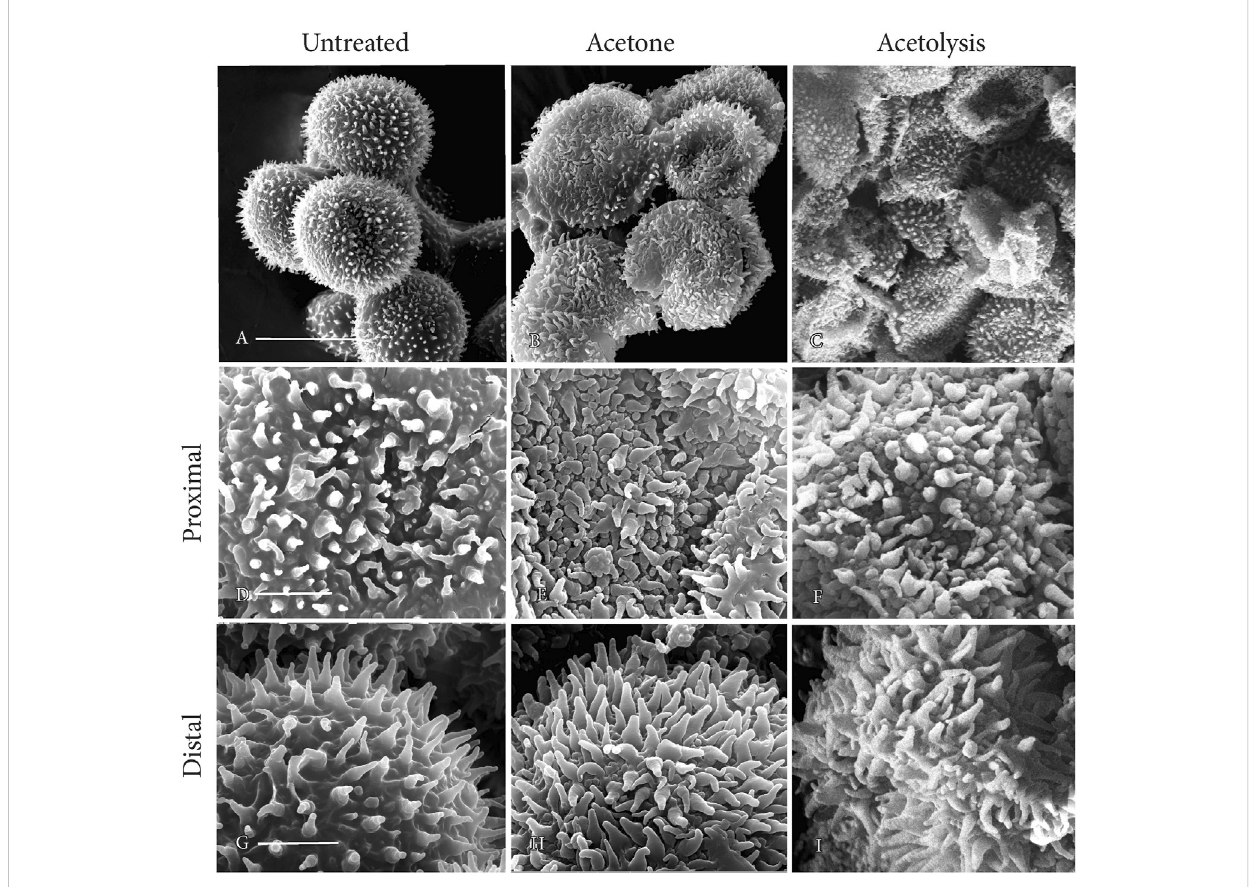
FIGURE 8 SEMs of mature spores. Perine ornamentation remains intact on both proximal and distal sides of spores after acetone treatment and acetolysis. (A, D, G) untreated; (B, E, H) acetone treated; and (C, F, I) acetolysis treated. Scale bars: (A − C) = 20 μ m; and (D − I) = 5.0 μ m.